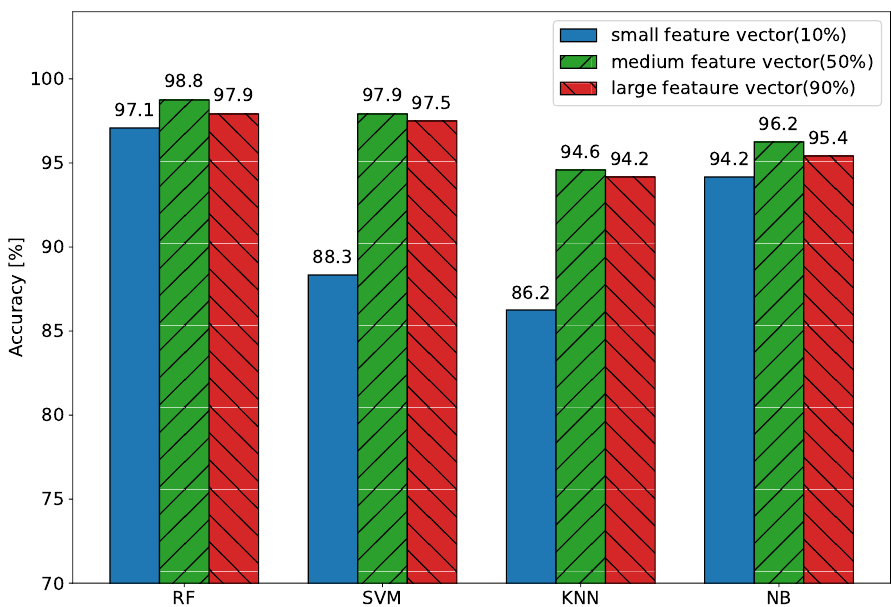
Figure 12. Accuracy scores of all 16 models trained by the watch data set of the watch session. Each model type was trained with three different feature vector sizes and tested against the held-back test data set.